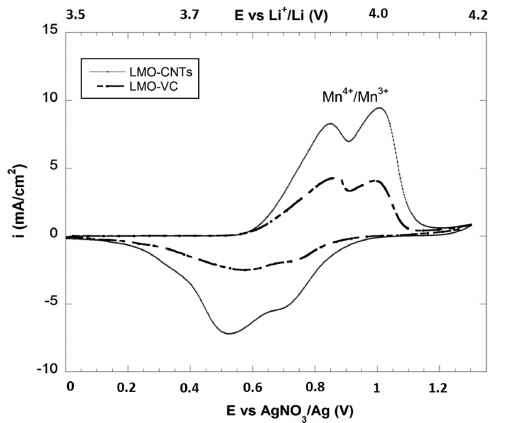
Figure 10. CV curves of LNMO/CNTs (2 wt%) nanocomposites (solid line) and LNMO/VC (2wt%) (dash dot